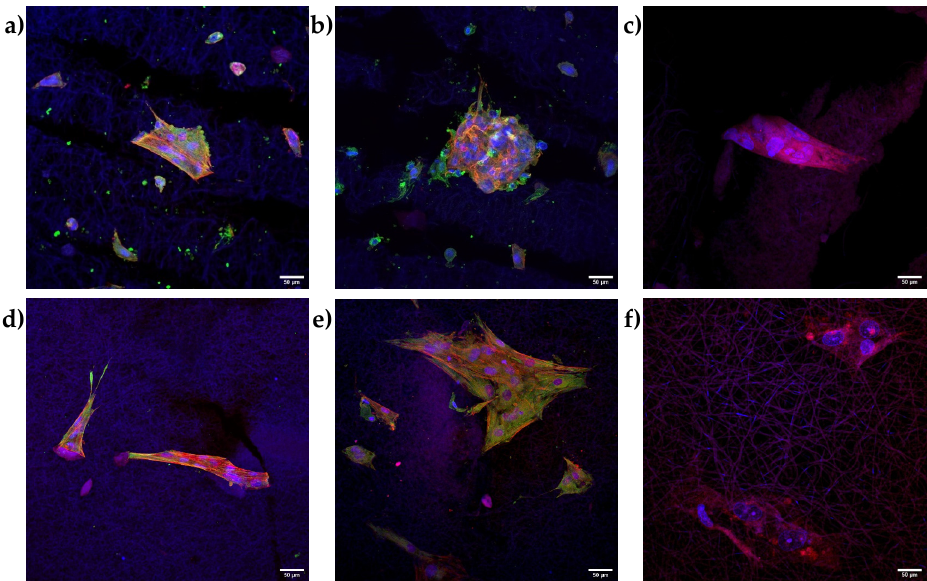
Figure 9. CLSM images of hASCs grown onto the A-B ( a – c ), ( upper row ) and R-HAP ( d – f ), ( lower row ), with ( b , e ) and without ( a , d ) CS in the medium, after 21 days. Actin stained in red, nuclei stained in blue, collagen I ( a , b ), ( upper row ) stained in green, sialoprotein ( d , e ), ( lower row ) stained in green. The right column ( c , f ) shows the negative control with A-B scaffolds stained with sialoprotein ( c ), ( upper row ) and R-HAP scaffolds stained with collagen I ( f ), ( lower row ) (magnifications: 20×).